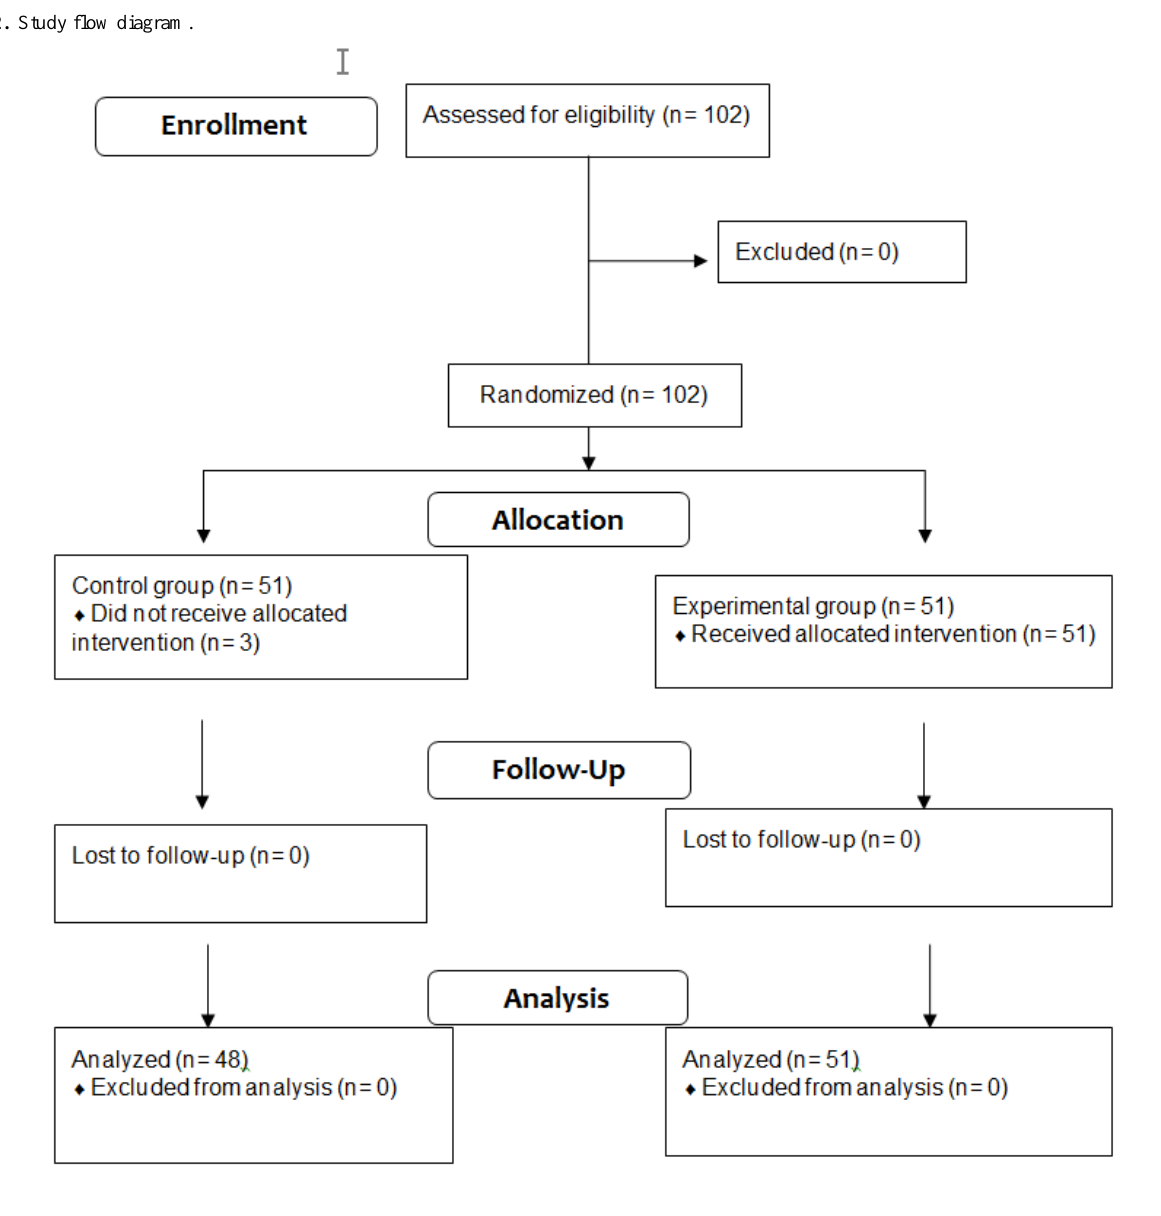
Figure 2. Study flow